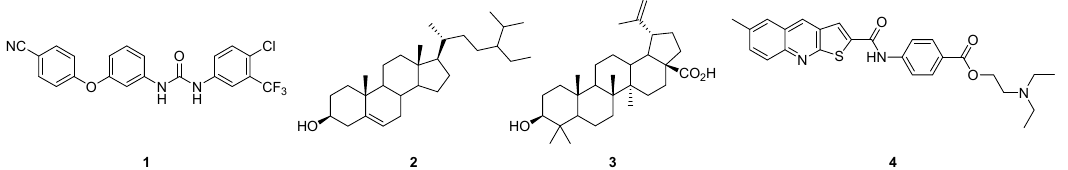
Figure 1. Representative compounds that have been reported to activate SHP1.